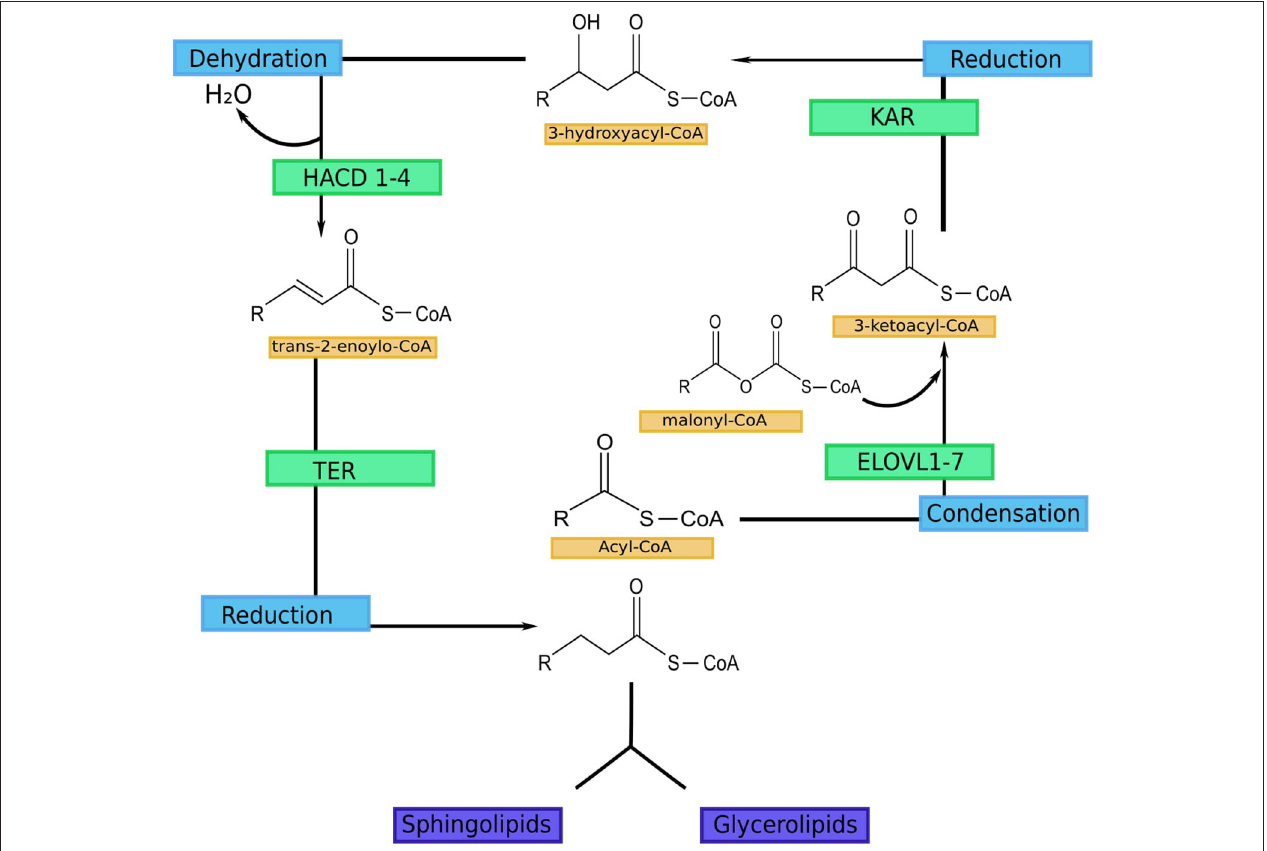
FIGURE 1 | FA elongation cycle with involved enzymes in each step (5). ELOVL1-7-fatty acid elongase 1-7 (ELOVL1 elongates SFA with chain lengths of 18–24 carbons, ELOVL2 elongates PUFA with 20–22 carbon and SFA with 18–20 carbon chains; ELOVL3 elongates SFA with chain lengths of 18–24 carbons; ELOVL4 elongates long-chain PUFA and long-chain SFA of 24 carbon length to VLC-PUFA and VLC-SFA ( ≥ 26 carbons; ELOVL5 mediates elongation of long-chain PUFA and long-chain SFA between 18 and 22 carbons in length; ELOVL6 elongates SFA, MUFA and PUFA with 12–18 carbon chains; ELOVL7 elongates SFA with chain lengths of 18–22 carbons); KAR, 3-ketoacyl-CoA reductase; HACD 1-4, 3-hydroxyacyl-CoA dehydratase; TER, trans-2-enoyl-CoA